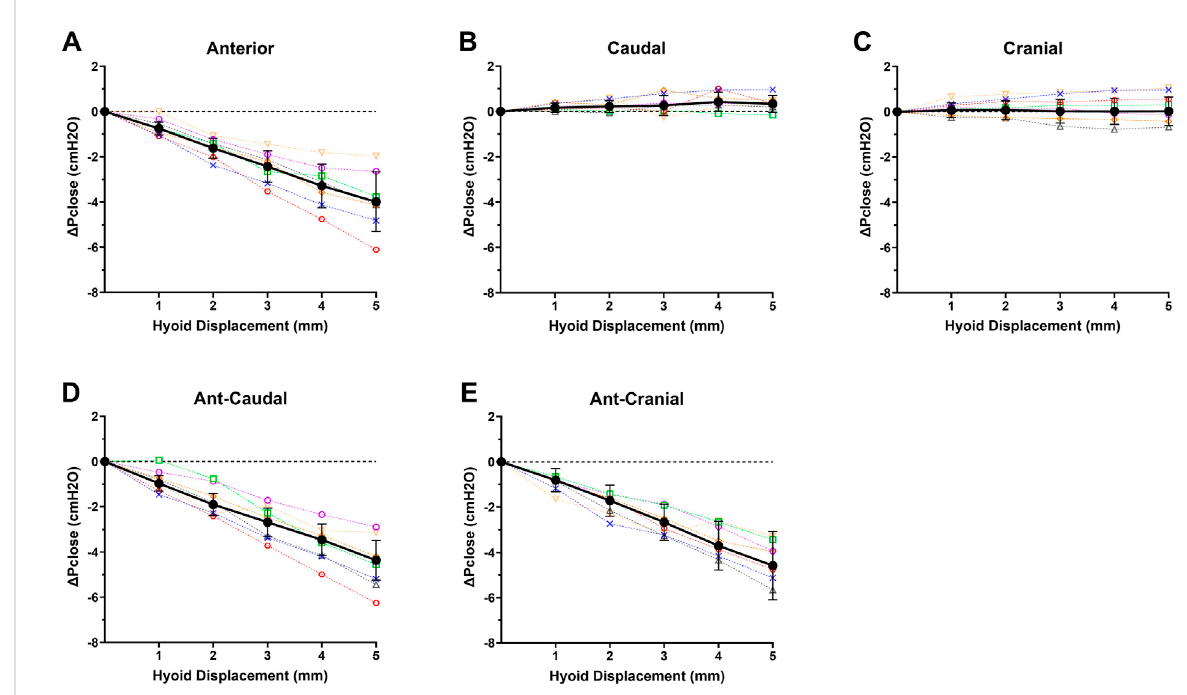
FIGURE 4 Individual rabbit( n =7;opensymbols,dashedinterpolatedline)andgroupmean±SD(closed darkcircleswitherrorbarsrepresenting standard deviation, solid interpolated line) Δ Pclose vs increasing hyoid displacement for each displacement direction: (A) anterior, (B) caudal, (C) cranial, (D) ant-caudal, and (E) ant-cranial. Δ Pclose progressively decreased with hyoid displacement in all anterior based directions (A,D,E) , while there was no signi fi cant change in Δ Pclose for cranial and caudal